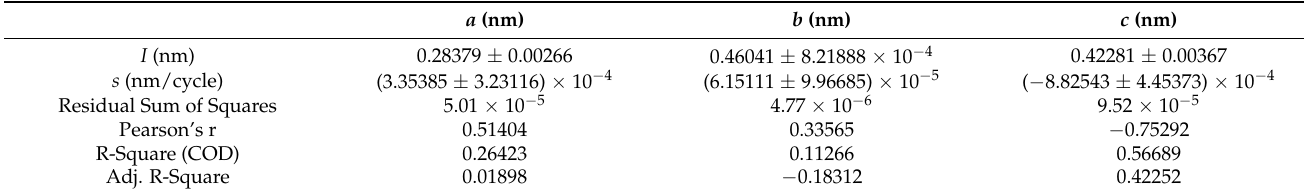
Table 4. Linear fit summary of the experimental values of unit cell parameters from Figure 11.